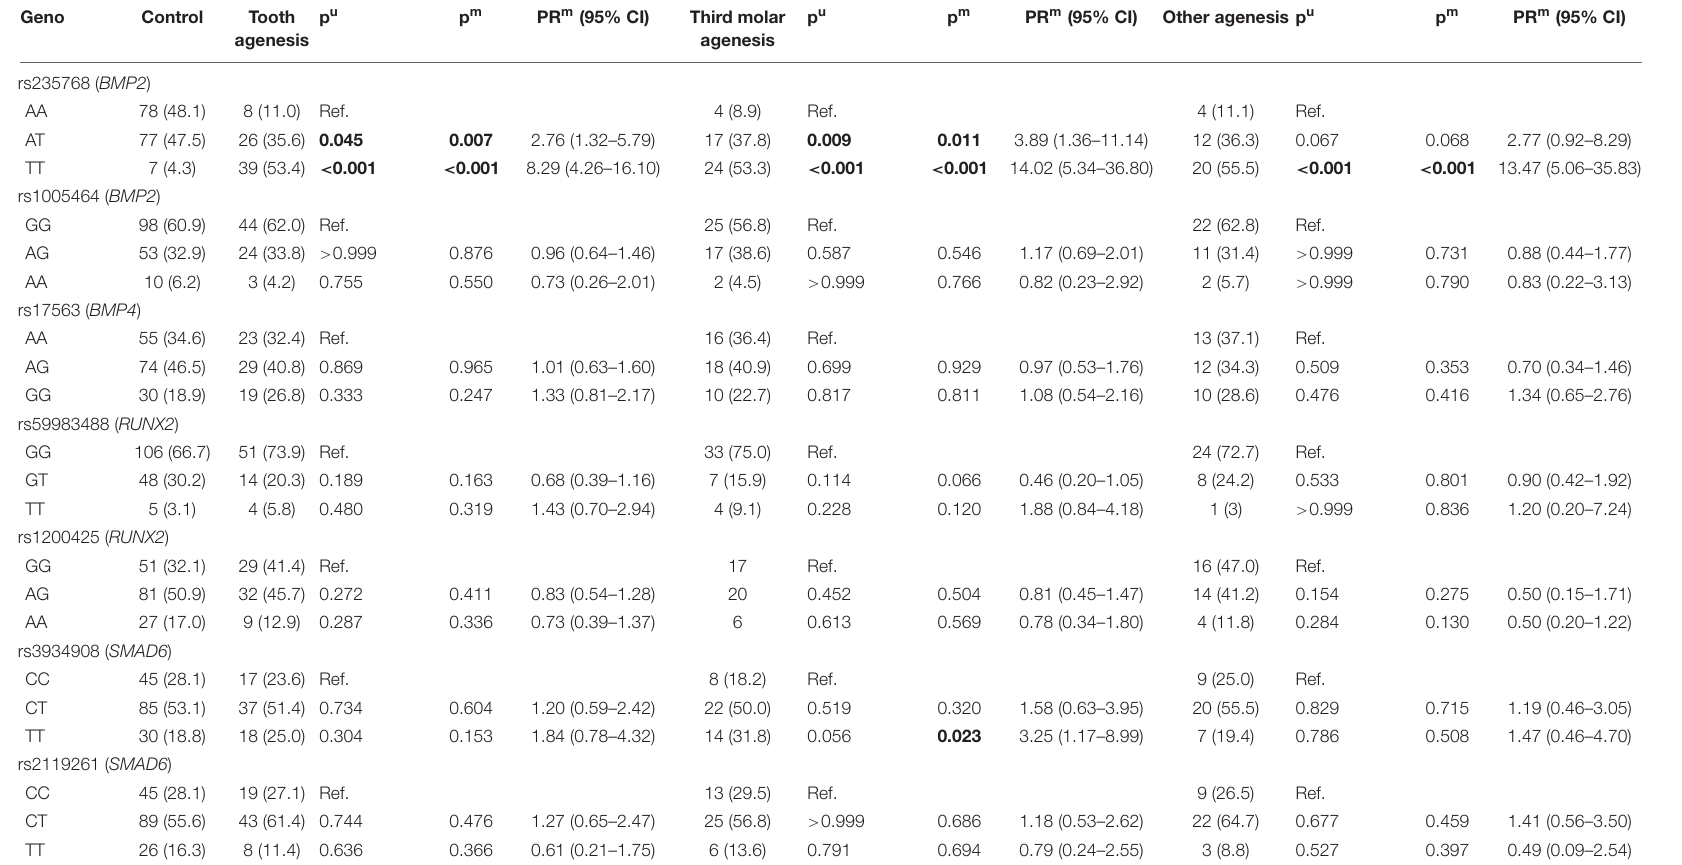
TABLE 4 | Genotypic distribution between